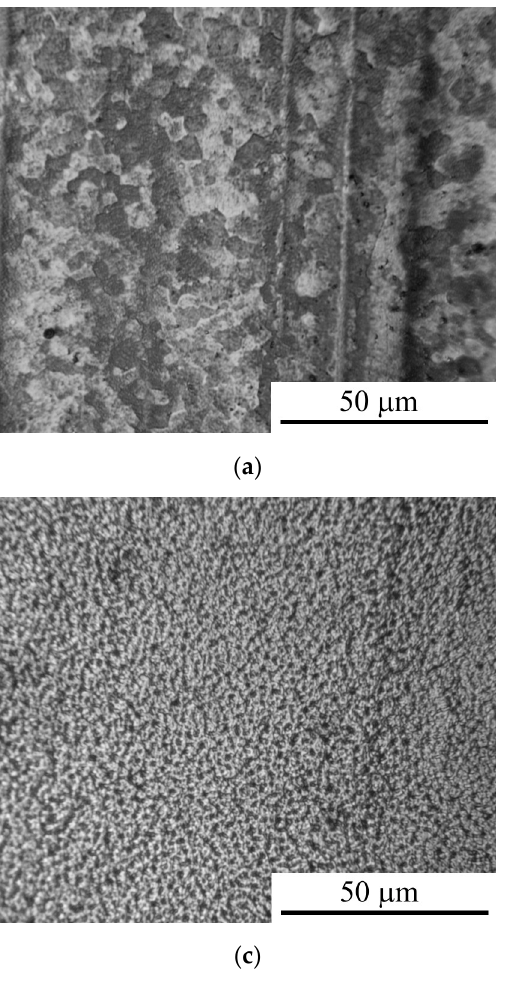
Figure 2. Morphology of the CP-Ti surface after anodic PENC at different treatment temperature: Table 1. Values of surface roughness, corrosion current density and corrosion potential of CP-Ti samples after anodic PENC at different temperatures.